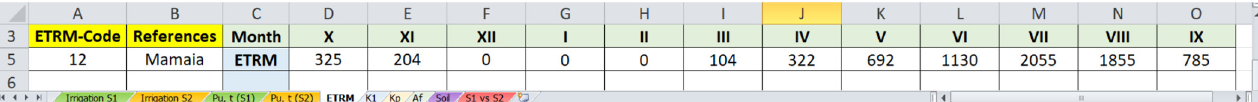
Figure 15. Average ETRM values in the neighborhood of CT, at Mamaia (5 km from CT) .